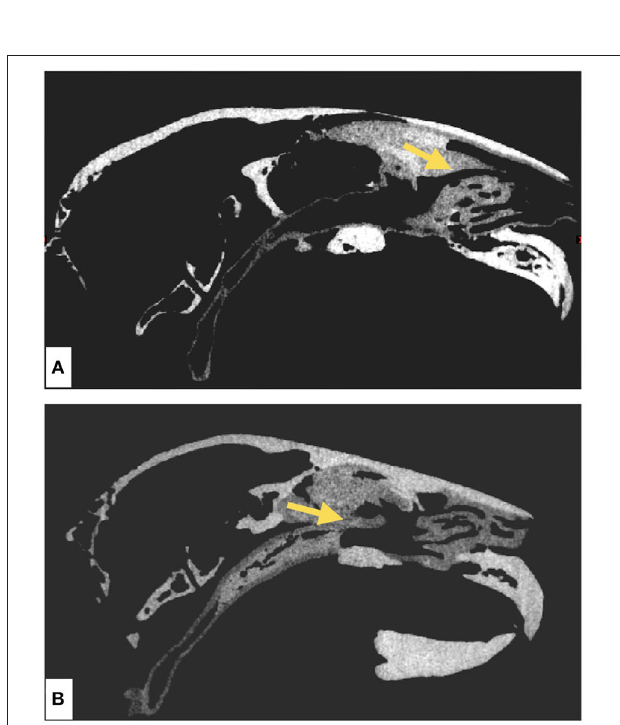
interest in mucosal and bony areas, respectively ( Figure 4